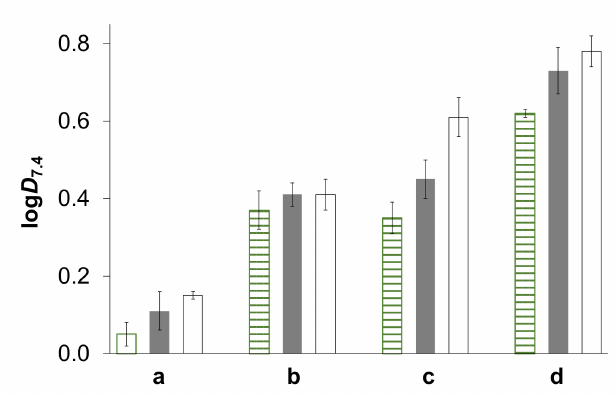
Figure 8. Lipophilicity of the title complexes expressed as log D 7.4 measured via n -octanol/water partitioning at pH = 7.40 at three types of chloride ion concentrations: 4 mM (stripped bar), 24 mM (grey bar) and 100 mM (white bar). a: RhCp*–HQCl-D-Pro, b: RhCp*–HQCl-D-hPro, c: